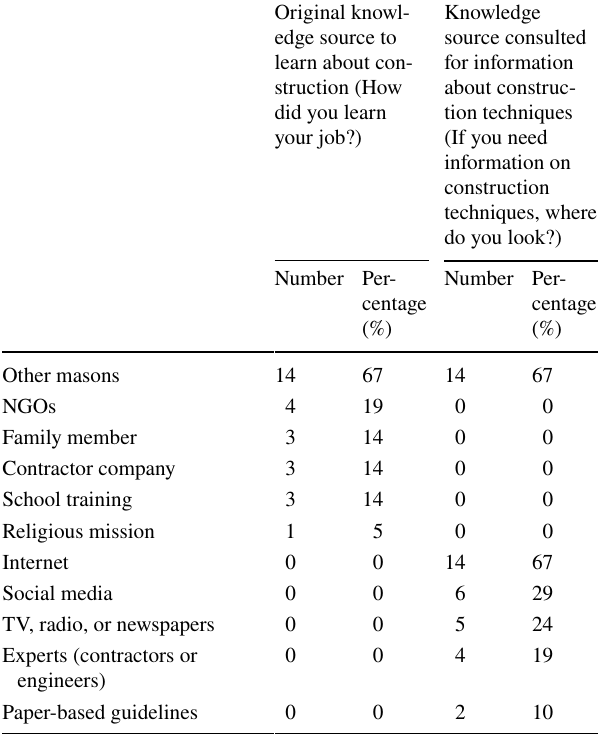
Table 3 Knowledge sources for learning and consultation used by masons ( N = 21) in Iringa, Tanzania Original knowl- edge source